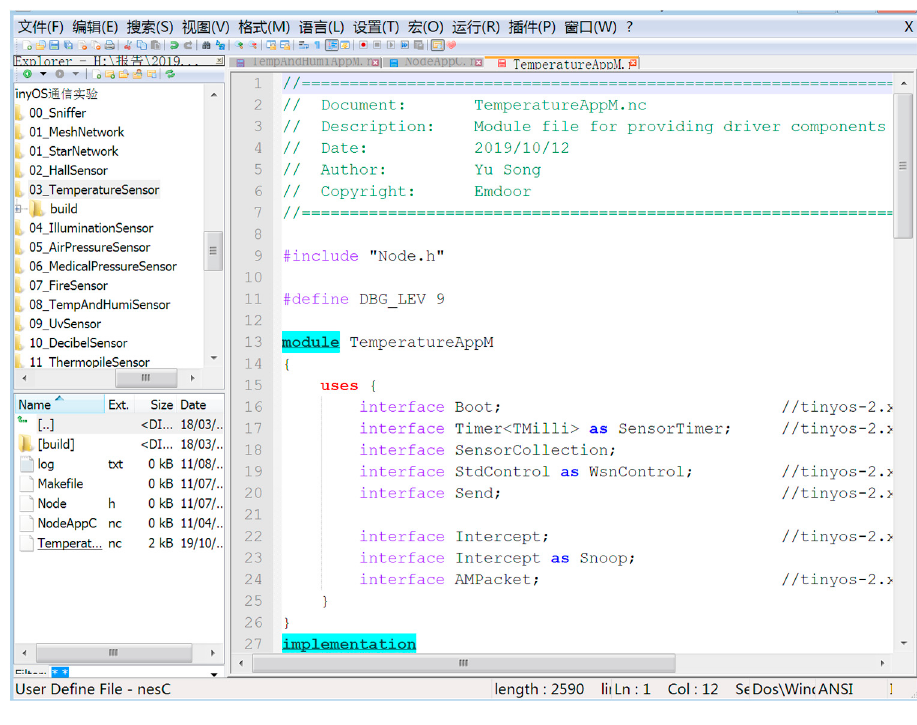
Figure 5. Compile the program.